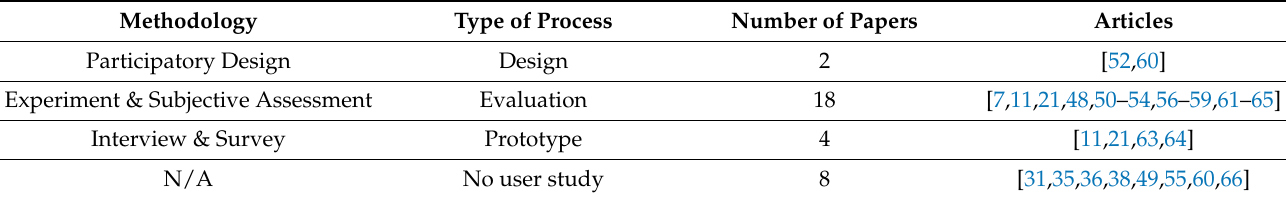
Table 5. BLV’s involvement in system design and